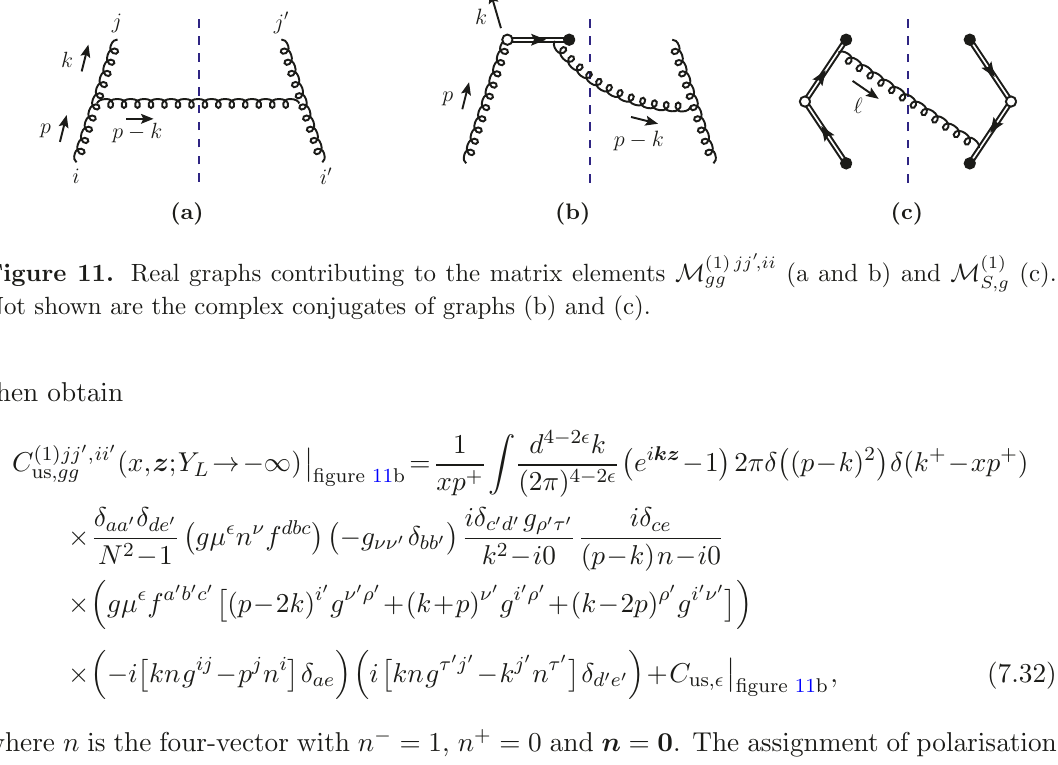
Figure 10. Virtual graphs contributing to the matrix elements Not shown are complex conjugate graphs and the analogue of (a) with a quark instead of a gluon loop. All eikonal lines are in the adjoint representation.